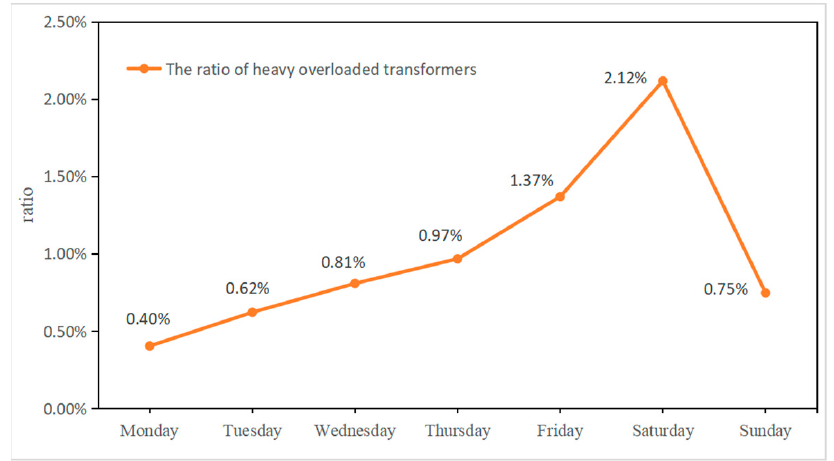
Figure 7. The ratio of heavy overload of public transformers in a certain area according to the weekly characteristics.